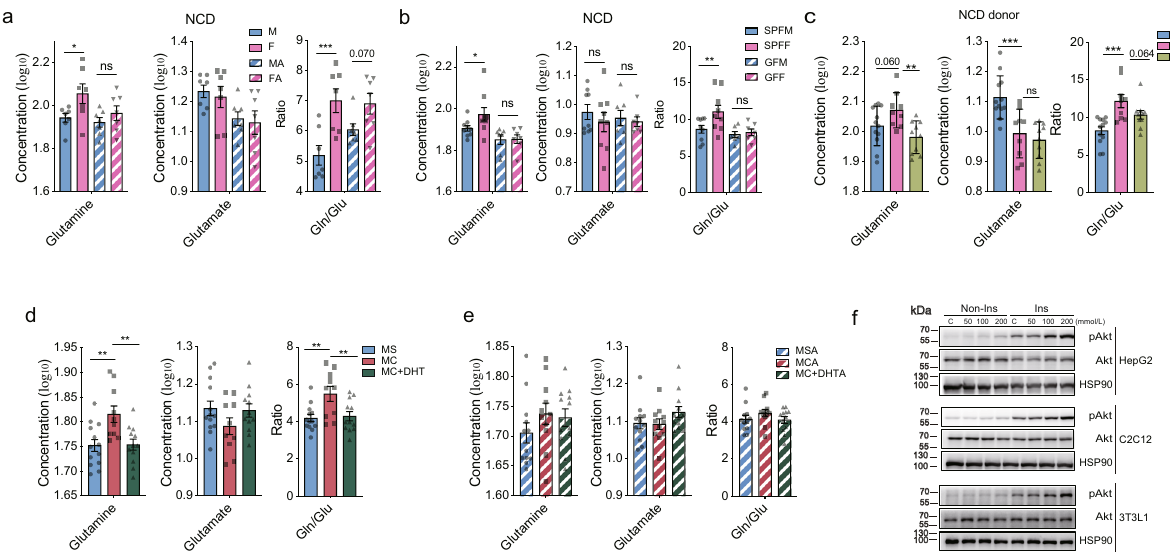
Fig. 5 Androgen in fl uences circulating glutamine and glutamine/glutamate (Gln/Glu) ratio via gut microbiome. a , Plasma concentrations of glutamine, glutamate, and Gln/Glu ratio in male and female mice fed a NCD without or with ABX treatment (in glutamine, for M VS F, P = 0.021; in Gln/Glu, for M VS F, P = 5.6 × 10 − 4 ) (mice, n = 7 per group). b Plasma concentrations of glutamine, glutamate, and Gln/Glu ratio in male and female SPF and GF mice (in glutamine, for SPFM VS SPFF, P = 0.042; in Gln/Glu, for SPFM VS SPFF, P = 0.009) (mice, n = 9 for SPFM and SPFF; n = 7 for GFM and GFF). c Plasma concentrations of glutamine, glutamate, and Gln/Glu ratio in the indicated groups in FMT experiment with feces from mouse donor fed a NCD (in glutamine, for M → M VS F → F, P = 0.060; for M → F VS F → F, P = 0.003; in glutamate, for M → M VS F → F, P = 6.7 × 10 − 4 ; in Gln/Glu, for M → M VS F → F, P = 1.8 × 10 − 4 and for M → F VS F → F, P = 0.064) (mice, n = 12 for M → M; n = 9 for F → F, n = 10 for M → F). d , e Plasma concentrations of glutamine, glutamate, and Gln/Glu ratio in the indicated groups in the castration and DHT supplementation experiment without ( d ) (in glutamine, for MS VS MC, P = 0.002 and for MC VS MC + DHT, P = 0.003; in Gln/Glu, for MS VS MC, P = 0.002 and for MC VS MC + DHT, P = 0.005) (mice, n = 13 for MS; n = 10 for MC; n = 12 for MC + DHT) or with antibiotics treatment ( e ) (mice, n = 12 for MSA, n = 11 for MCA; n = 12 for MC + DHTA). For a – e , the concentrations of glutamine and glutamate were calculated as log 10 and the ratio was calculated directly by the glutamine concentration to the glutamate concentration. f Representative western blotting of total and pAkt in the HepG2, differentiated C2C12, and 3T3-L1 cells of the indicated groups without or with 200 nmol/L insulin stimulation for 12 min. HSP90 was used as an internal control. This experiment was repeated independently for three times. M, male; F, female; MA, male mice after ABX treatment; FA, female mice after ABX treatment. SPFM, male speci fi c pathogen free mice; SPFF, female speci fi c pathogen free mice; GFM, male germ-free mice. GFF, female germ-free mice. M → M, male feces transferred to male recipients; F → F, female feces transferred to female recipients; M → F, male feces transferred to female recipients. MS, male sham mice; MC, male castrated mice; MC + DHT, male castrated mice injected with DHT; MSA, male sham mice under ABX treatment; MCA, male castrated mice under ABX treatment, MC + DHTA, male castrated mice injected with DHT under ABX treatment. Ins, insulin. * P < 0.05, ** P < 0.01, *** P < 0.001; ns, not signi fi cant. One-way ANOVA and the post hoc test of LSD (two-sided) were applied to analyze the data in Fig. 5 a – e . Data are expressed as mean ± SEM. Source data are provided as a Source Data fi